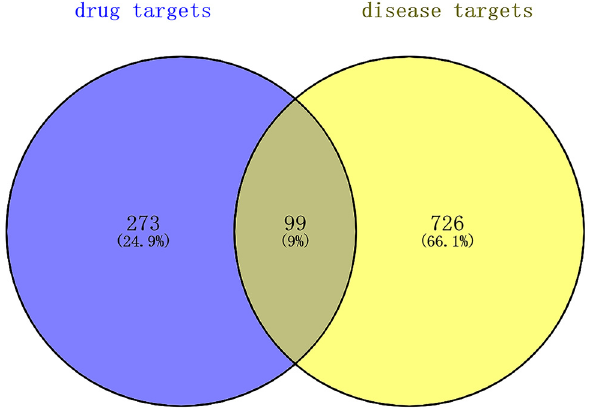
Figure 2: Intersection targets between C. sinensis and RIRI. The blue circle represents the targets of active components of C. sinensis ; the yellow circle means the disease - related targets; and the middle region represents the intersection